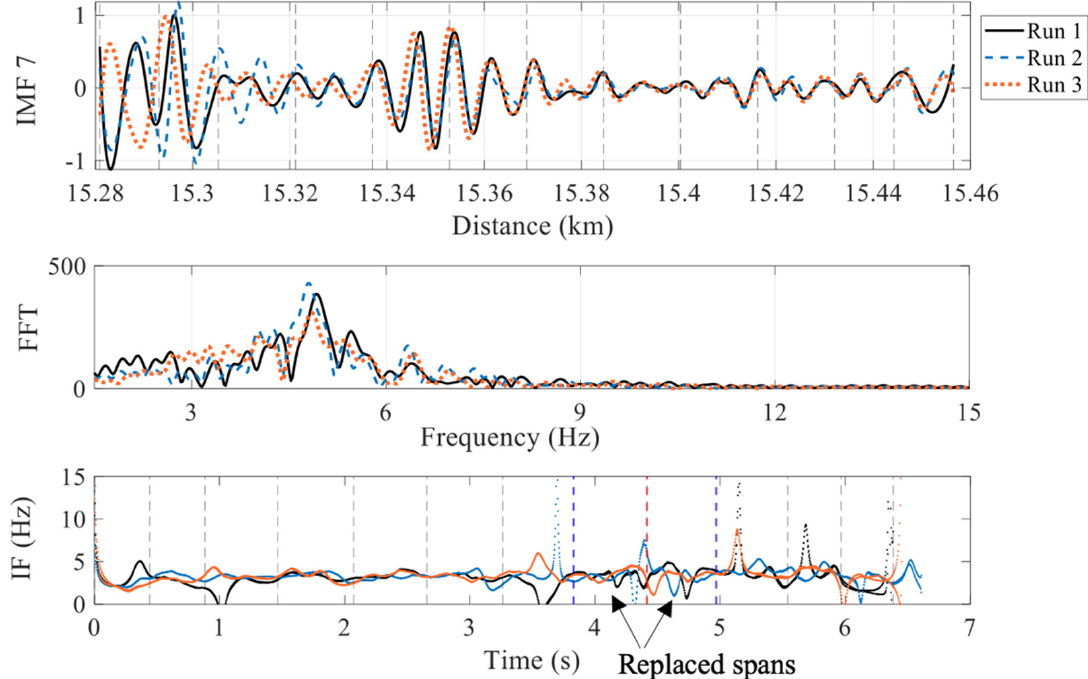
Figure 11. IF-7 and FFT calculated from IMF 7 (showing a range of frequencies closer to the spans natural frequencies) (red dashed line = replaced pier; blue dashed lines = boundary between the new and the other spans).